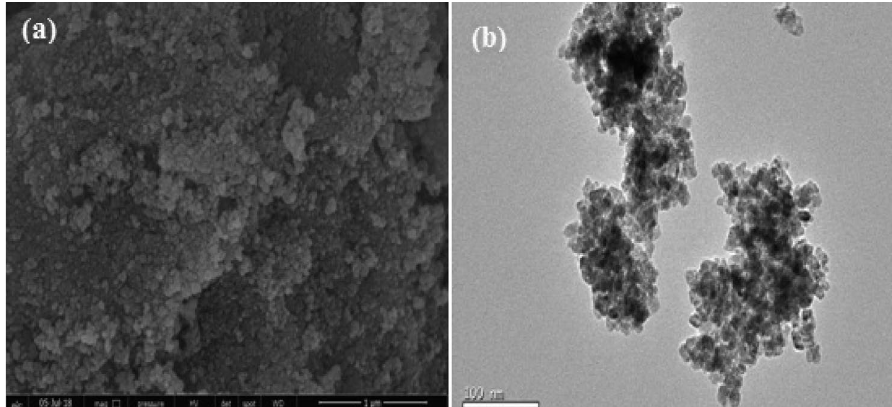
Figure 6. (a) SEM and (b) TEM images of YbPO 4 :Tb 3+